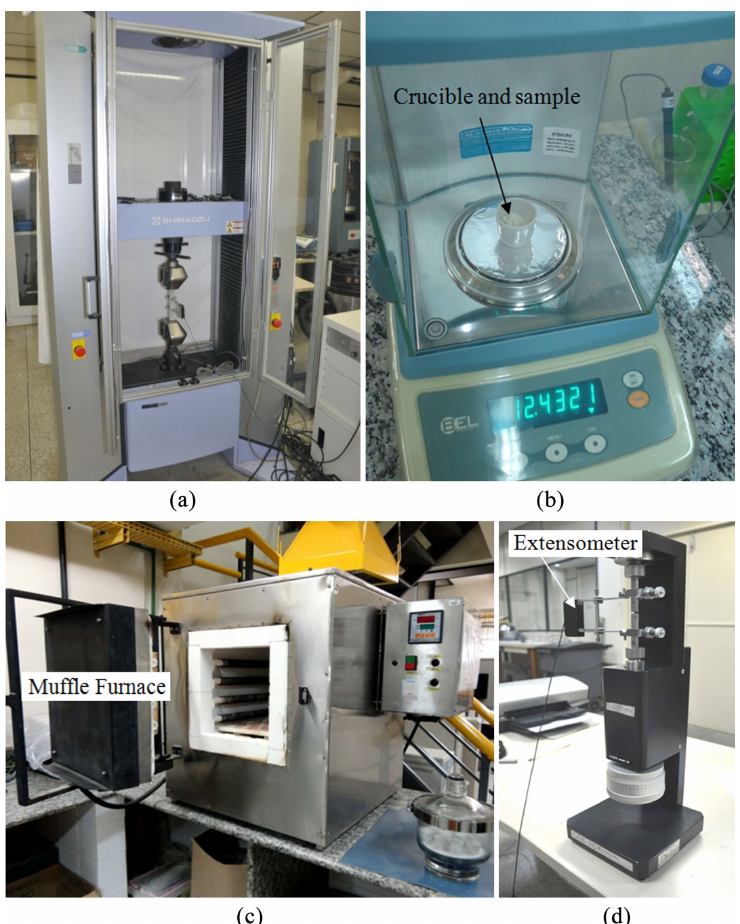
Figure 3. Equipment used in the performed tests: (a) Shimadzu Autograph  AG-X 100 kN universal testing machine, (b) weighing machine, (c) INTI  muffle furnace and, (d) Shimadzu  CDE-25 C1 (model)